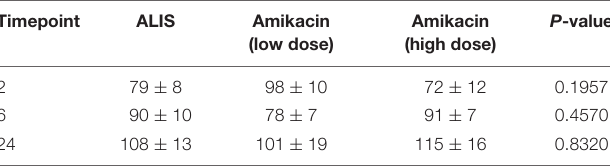
TABLE 3 | Protein concentrations of cell pellets collected by bronchoalveolar lavage (BAL). Timepoint